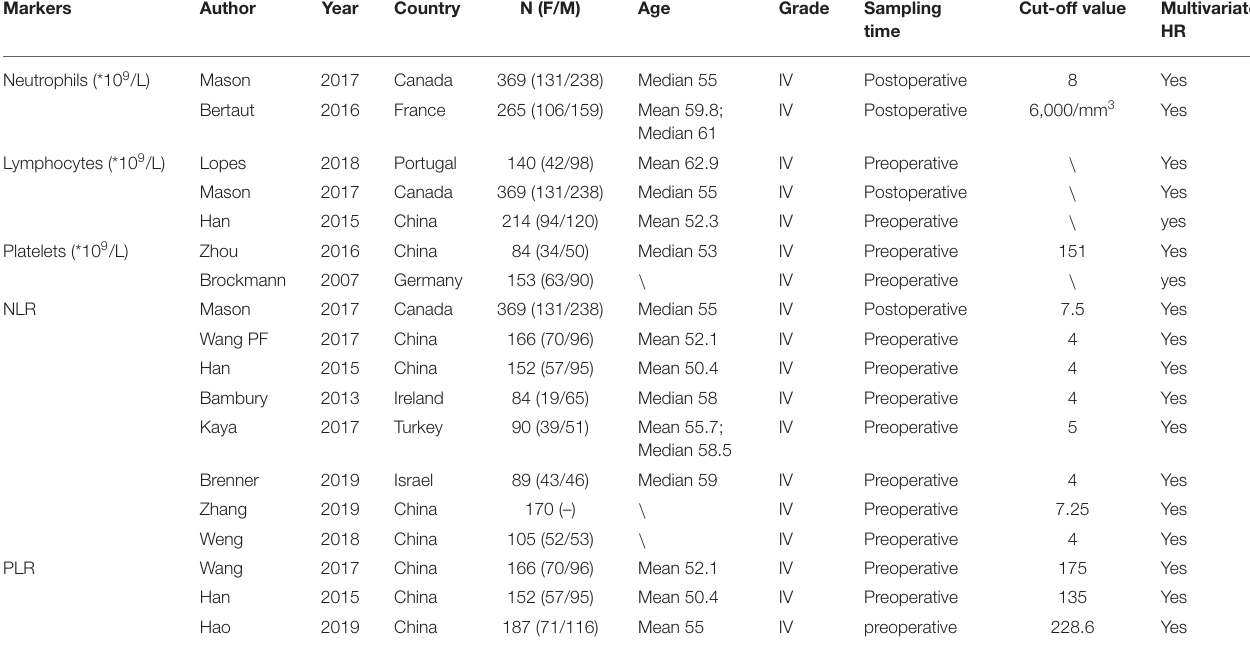
TABLE 2 | Characteristics of the included studies. Markers